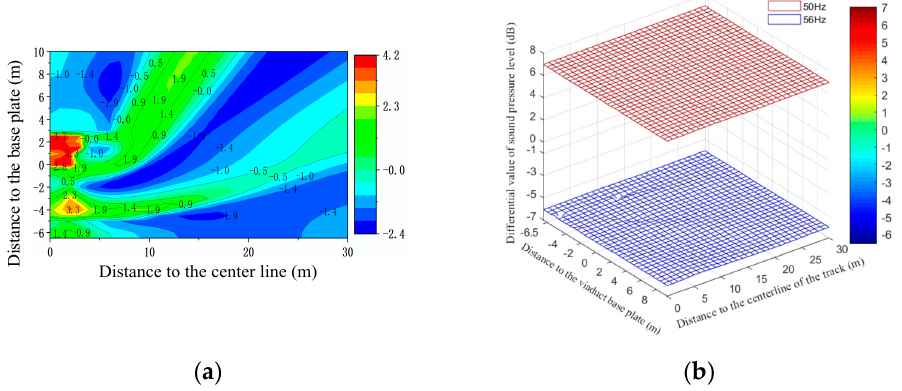
Figure 14. The cloud diagram of the sound pressure level difference (dB); ( a ) the total sound pressure level difference of transverse sound field under conditions 1 and 2 ( S 2 i − S 1 i ); ( b ) the insertion loss of sound pressure level in transverse sound field under conditions 1 and 2 (50 Hz, 56hz).